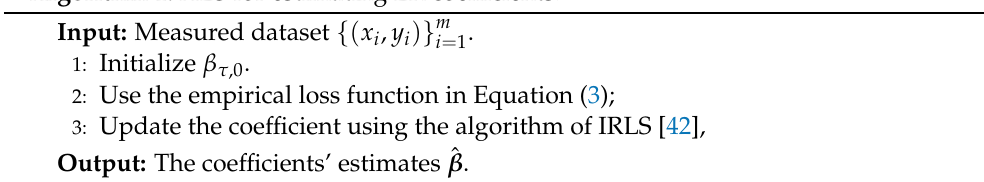
Algorithm 1: ALS for estimating ER